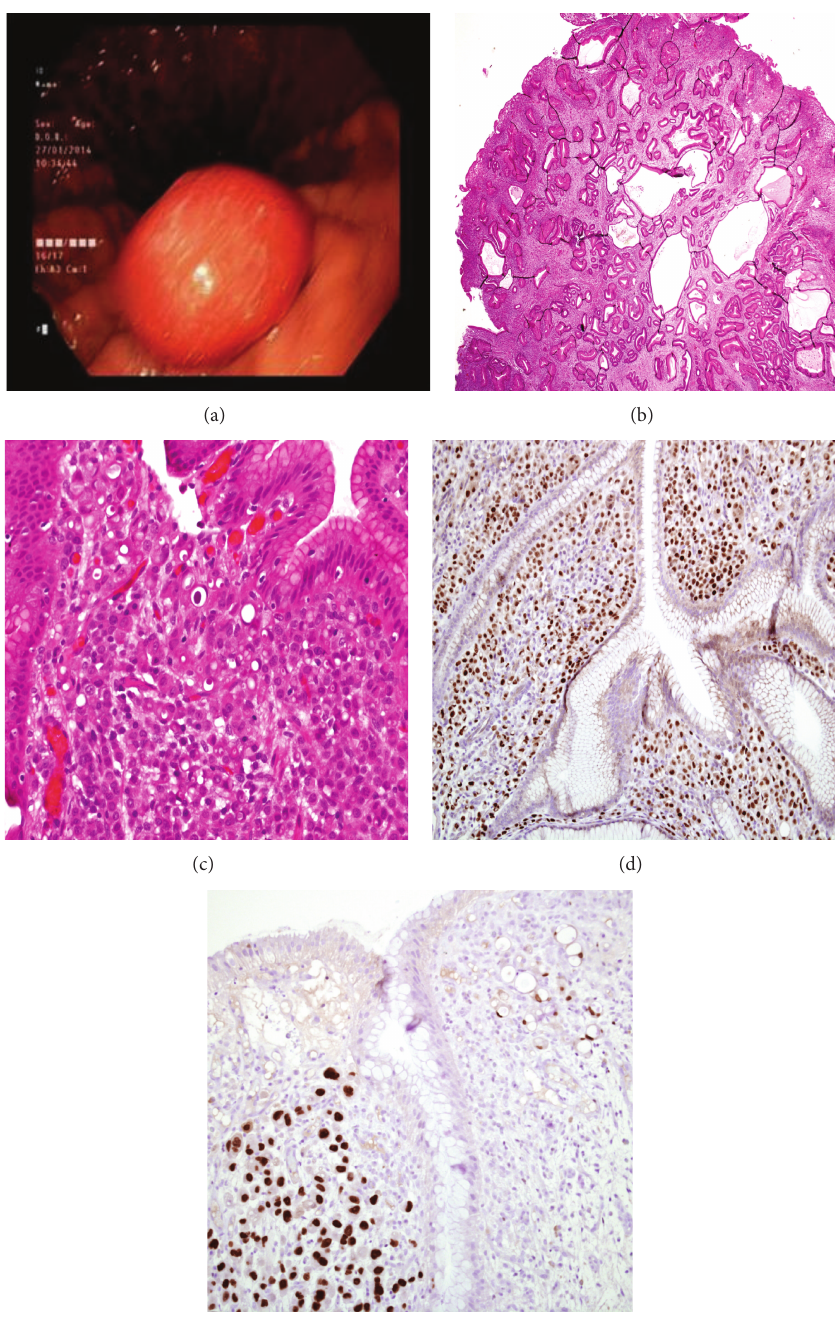
Figure 1: (a) Endoscopic view of gastric polyp. (b) Low power microscopic view of the excised lesion showing typical features of gastric hyperplastic polyp, namely, elongated, tortuous, and cystic foveolae separated by edematous and inflamed stroma (hematoxylin and eosin stained section, magnification × 20). (c) High power view shows carcinoma cells, including signet ring cells, infiltrating the lamina propria among benign gastric foveolae (hematoxylin and eosin stained section, magnification × 400). (d) Estrogen receptors and (e) GATA3 strongly stain the nuclei of the cancer cells while the gastric epithelial cells remain negative for both markers ((d) and (e) magnification ×